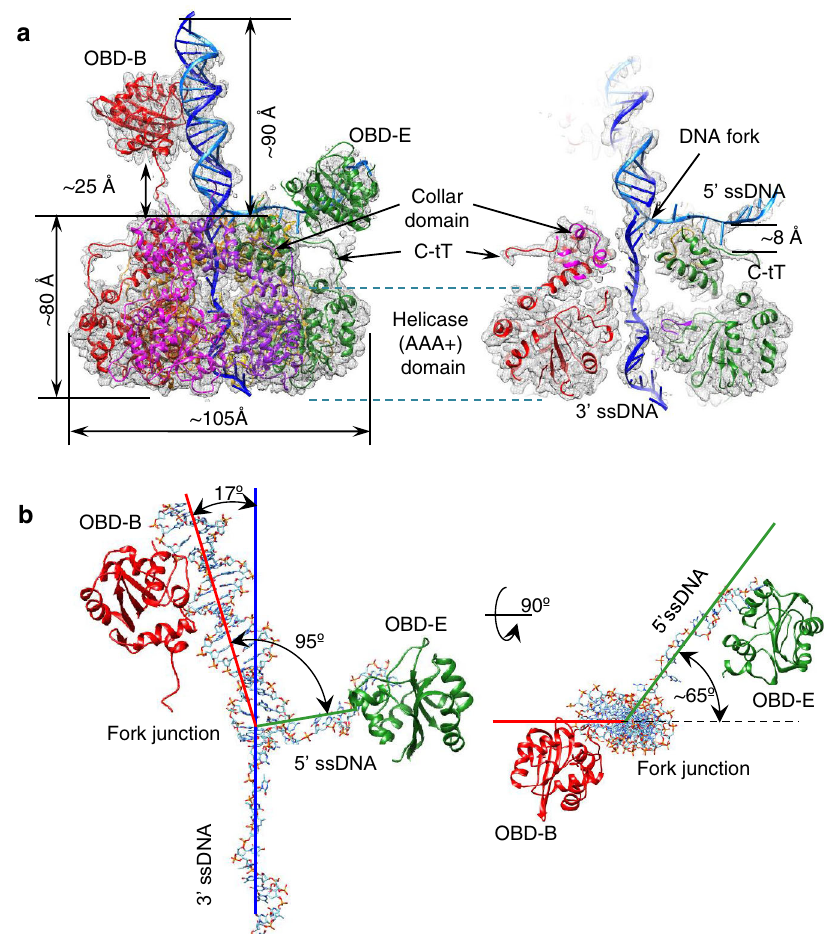
Fig. 2 The E1RF structure. a Side view (left) and vertical central slice (right) of the E1RF EM map (in grey), with the fi tted atomic models of the RF DNA (blue) and E1HD and OBD domains. Subunits A – F of the E1RF are shown in pink, red, orange, yellow, green, and purple correspondingly (and in all subsequent fi gures). b Fitted atomic model of the unwinding replication fork and OBD B and OBD E interacting with the dsDNA and 5 ′ ssDNA strands, respectively, viewed from the side (left) and top (right). The angles between the dsDNA and the 5 ′ ssDNA are